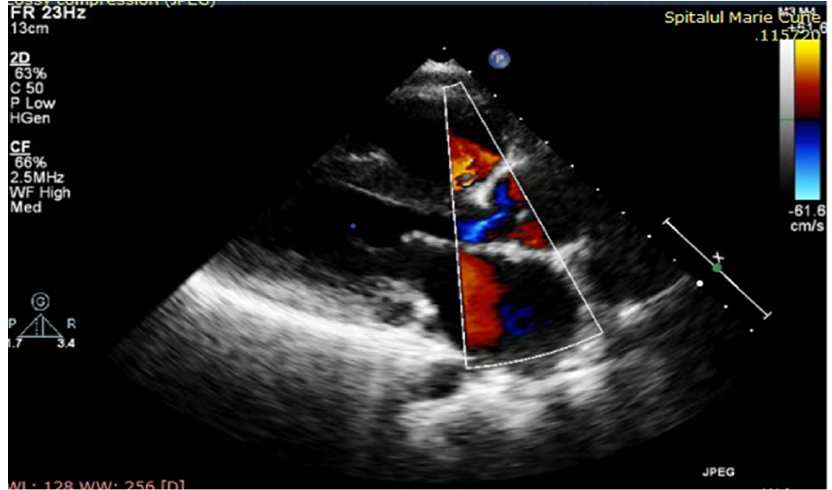
Figure 3. TTE at one-year follow-up: minor regurgitation of neoaorta.